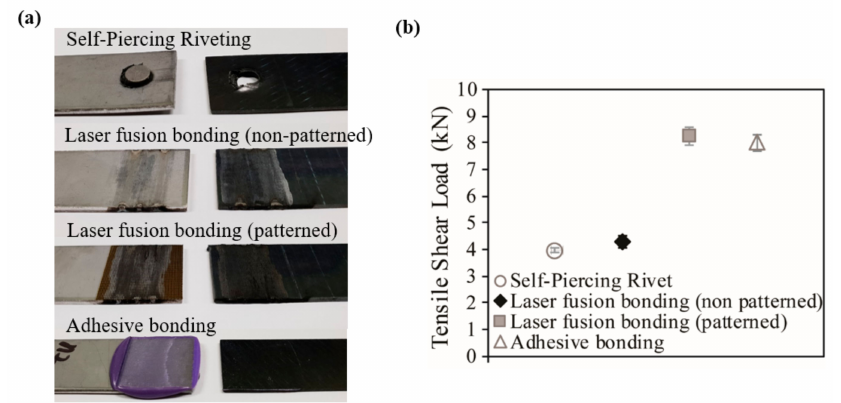
Figure 9. The failure surfaces and the tensile shear load test results of joints between CFRP and zinc-coated steel formed by four di ff erent methods: self-piercing rivet, laser fusion bonding with and without the pre-inscribed patterns, and adhesive